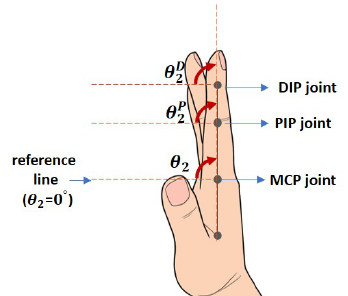
Figure 6. Illustration on the goniometry of the pointer finger and its’ reference line. The figure shows θ 2 = 90 ◦